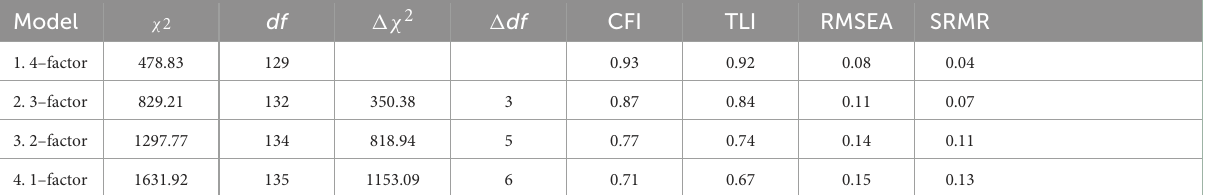
TABLE 2 Results of confirmatory factor analysis of study